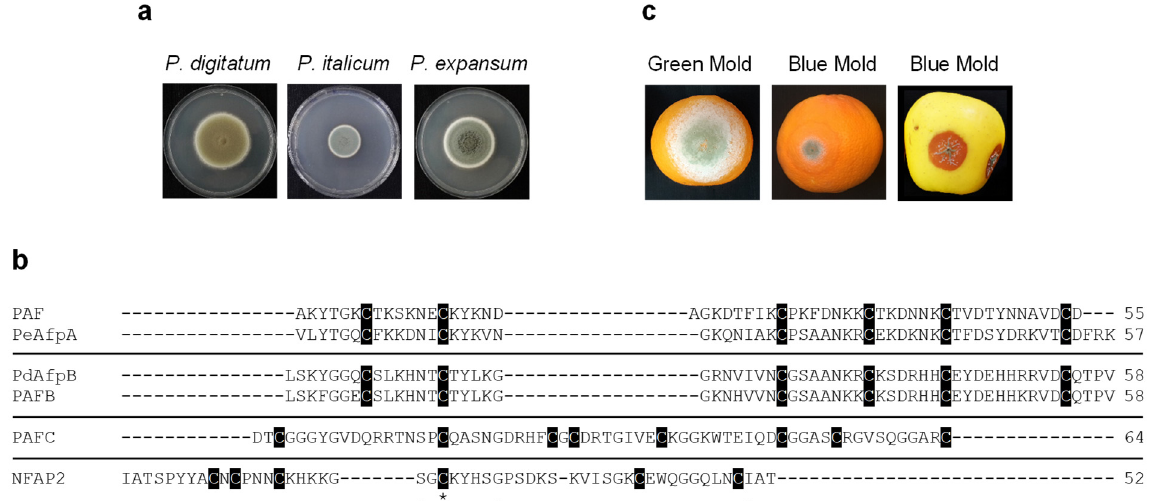
Figure 1. Penicillium species and antifungal proteins (AFPs) evaluated. ( a ) Representative images of growth on PDA plates of P. digitatum PHI-26 CECT 20796, P. italicum PHI-1 CECT 20909 and P. expansum CMP-1 CECT 20906 strains. ( b ) Amino acid sequence alignment of the tested AFPs. Phylogenetically different proteins are separated by a line. Conserved amino acids are represented with (*). Other conserved amino acids are represented with (.). Cysteine residues are shadowed in black. Amino acid alignment was performed using Clustal Omega (https://www.ebi.ac.uk/Tools/msa/clustalo/ (accessed on 28 November 2020)). The number of amino acids of proteins is also shown at the end of the amino acid sequence. ( c ) Images of infected orange fruits with P. digitatum (green mold) and P. italicum (blue mold) and infected apple fruits with P. expansum (blue mold) at 7 days post-inoculation (dpi).